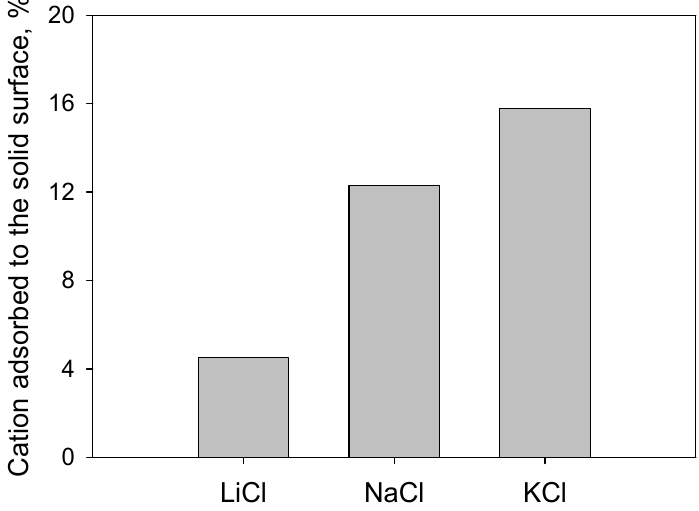
Figure 12. Percentage of cation adsorbed on silica. Initial salt concentration was 0.01 M.